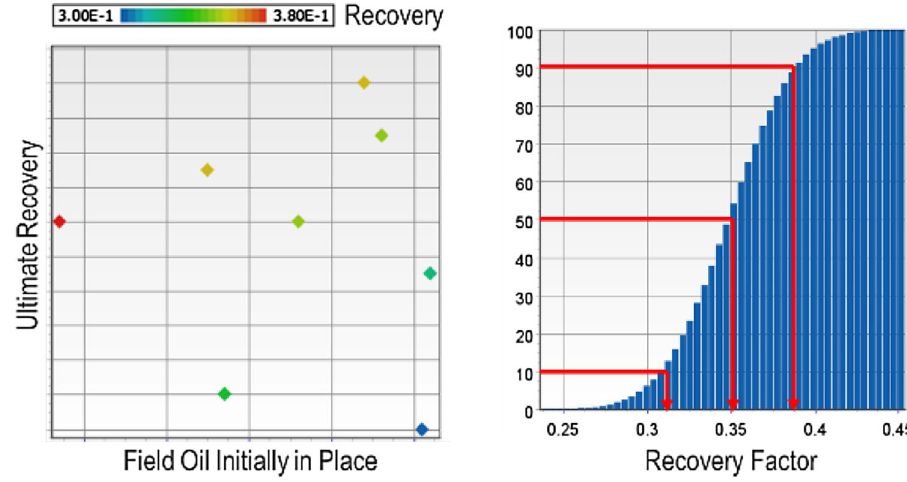
Fig. 15 Left: 8 selected predic‑ tion cases shown in a cross plot ultimate recovery vs. field oil initially in place. The color cod‑ ing of the data points indicates the range of recovery factors. Right: a distribution of recovery factors is created from Monte Carlo Simulation with P10, P50 and P90